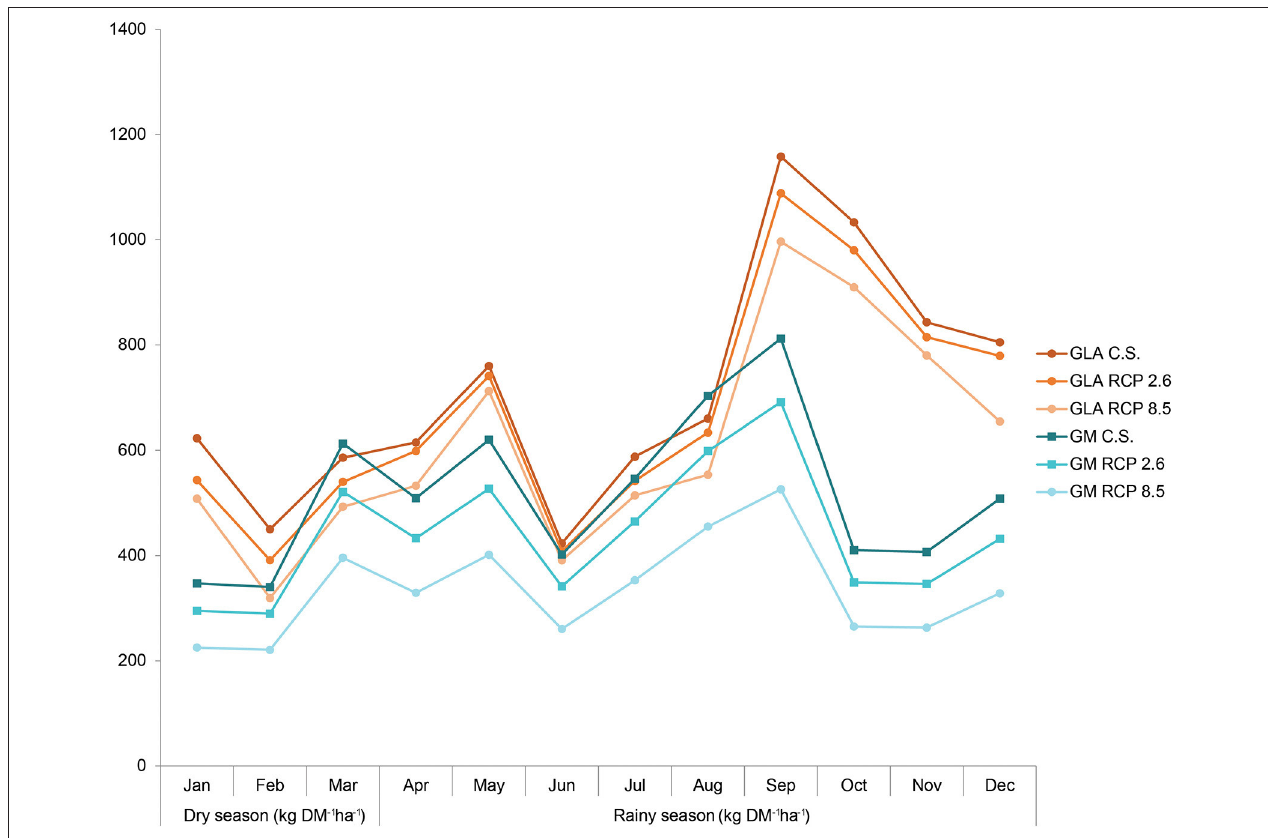
FIGURE 5 | Dry Matter (DM) production under climate change scenarios (RCP 2.6 y 8.5) and Current Scenario (C.S). GLA, Grass-legume association; GM, Grass